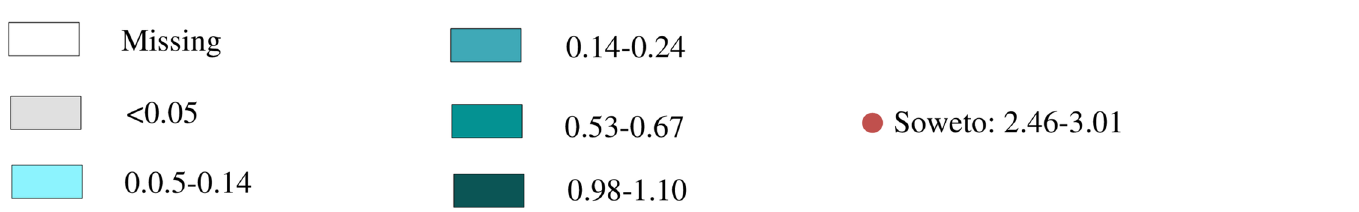
PLOS ONE | DOI:10.1371/journal.pone.0152524 April 7,